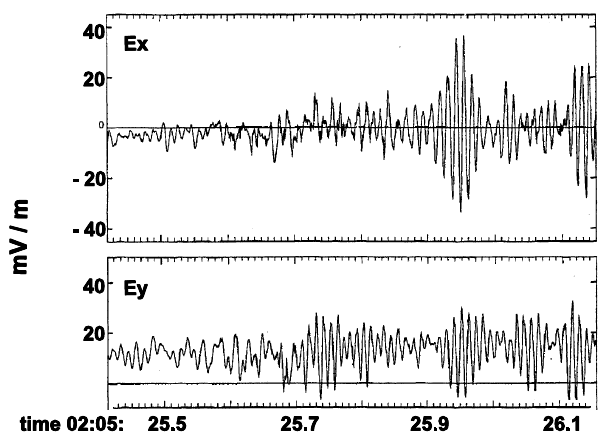
Fig. 1. Nonlinear “oscilliton” structures associated with the LH mode (adapted from Fig. 3 of Cattell et al., 1998). The measurement was performed by the Polar satellite at the plasma sheet boundary. LH mode, see, e.g., a detailed discussion by Cattell et al.